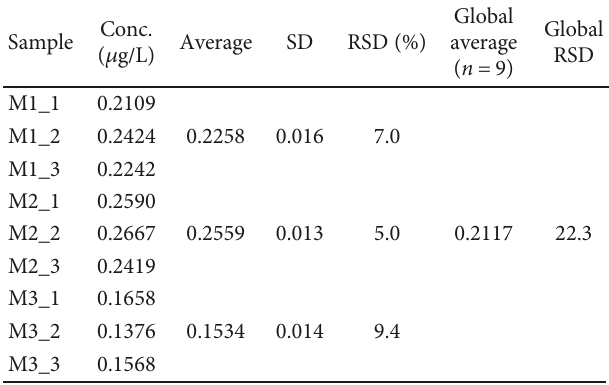
Table 8: Degradation results for ketorolac with ultraviolet